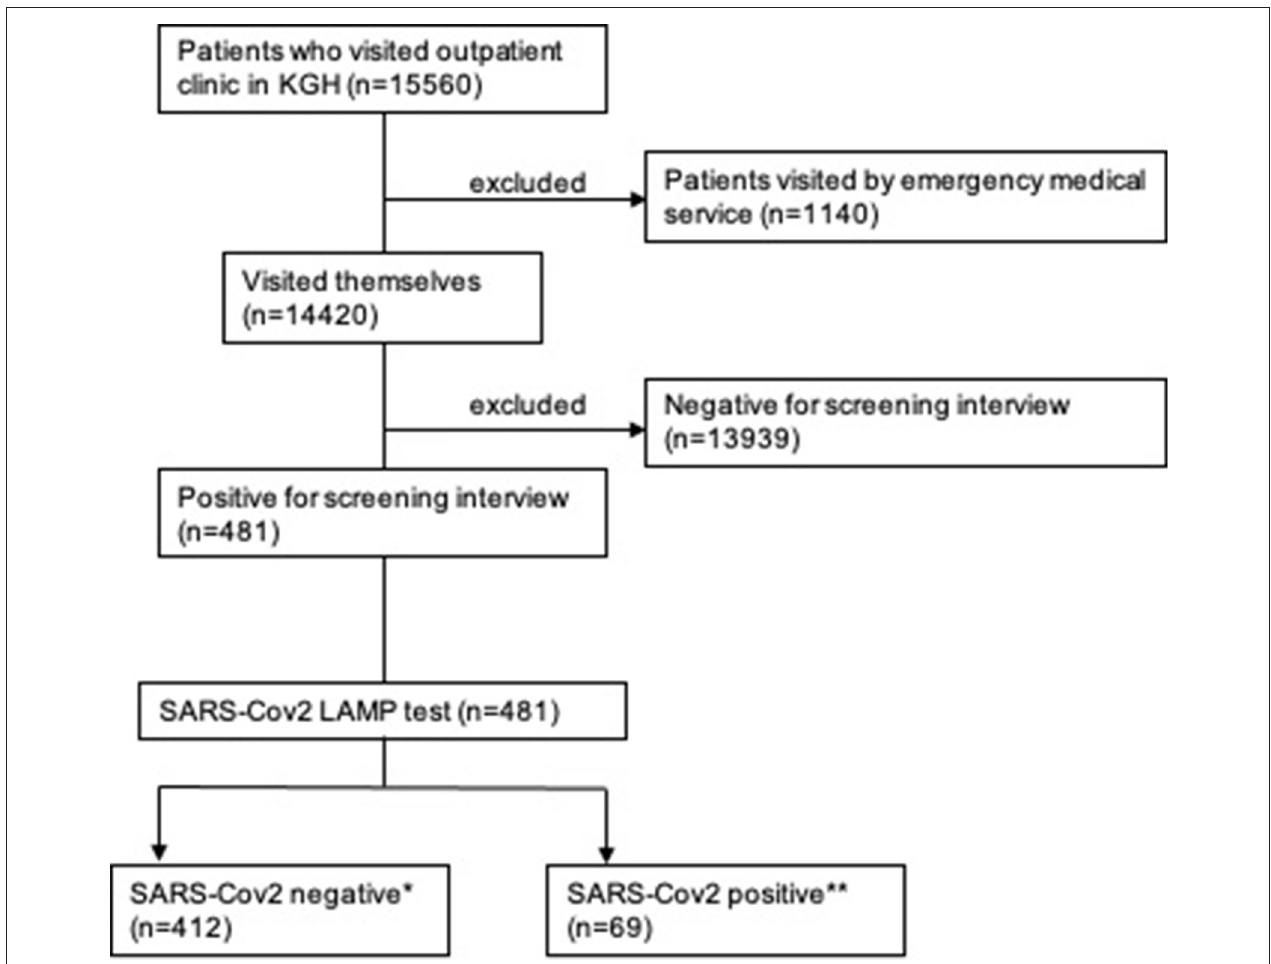
FIGURE 1 | Flow diagram of the inclusion and exclusion criteria used in this study. *negative group, **positive group. KGH: Kamagaya General